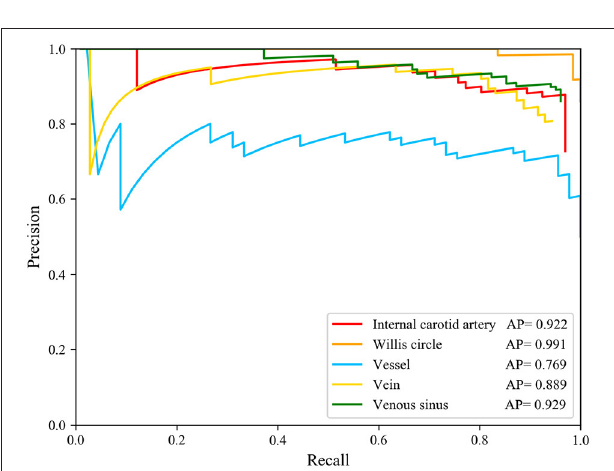
FIGURE 4 | Precision-Recall curve of five structure and AP value of each structures. The AP of the internal carotid artery is 0.922, of the circle of Willis is 0.991, of the vein is 0.889, of the venous sinus is 0.929, and of the venous blood vessel is 0.769.